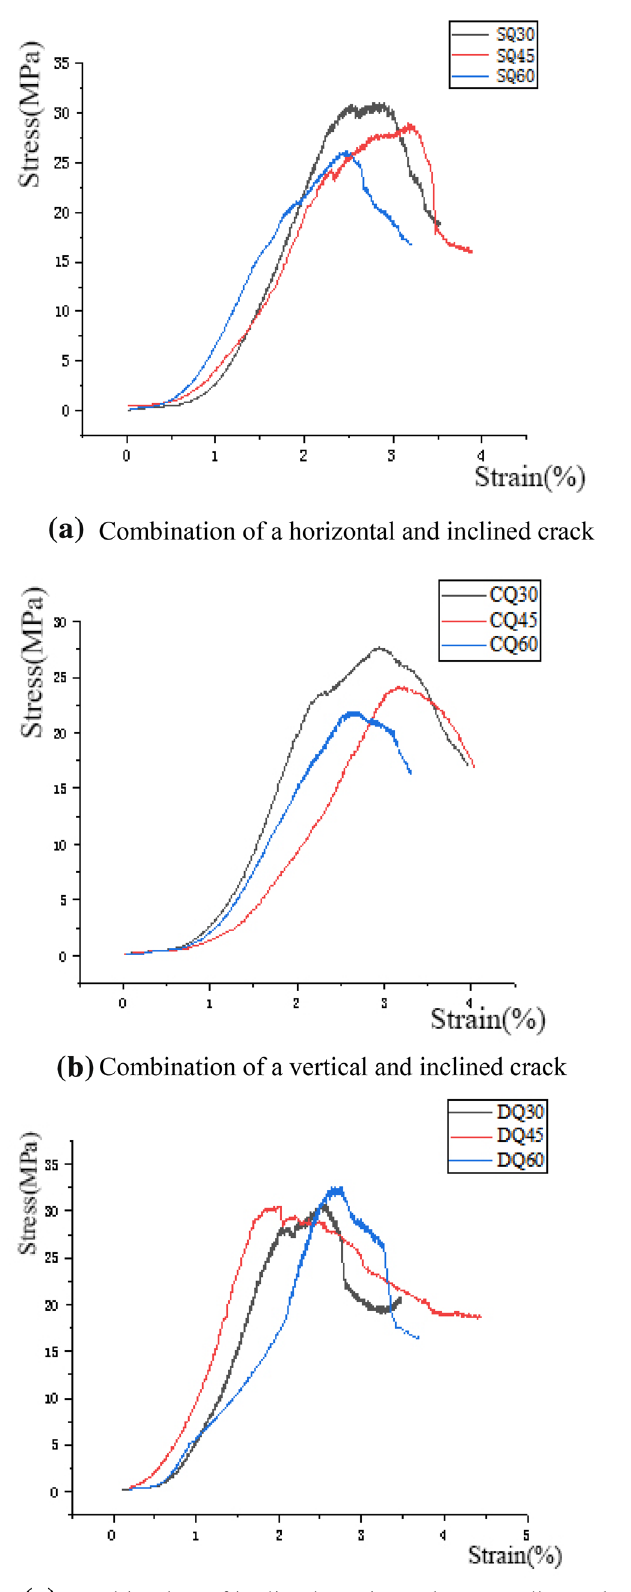
Fig. 5 Stress-strain curves of specimen with different dip